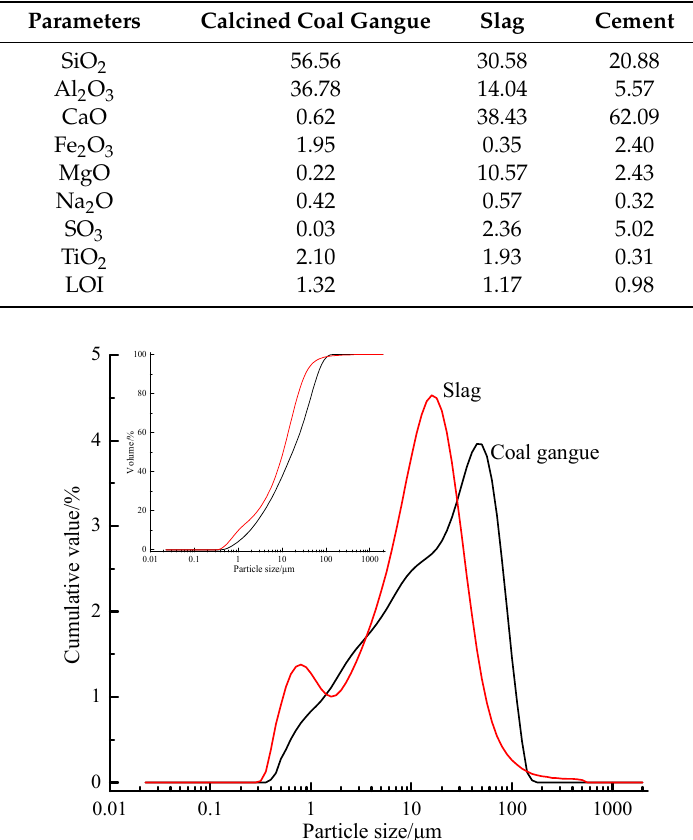
Table 1. Chemical component of calcined coal gangue, slag and cement (mass fraction, %).